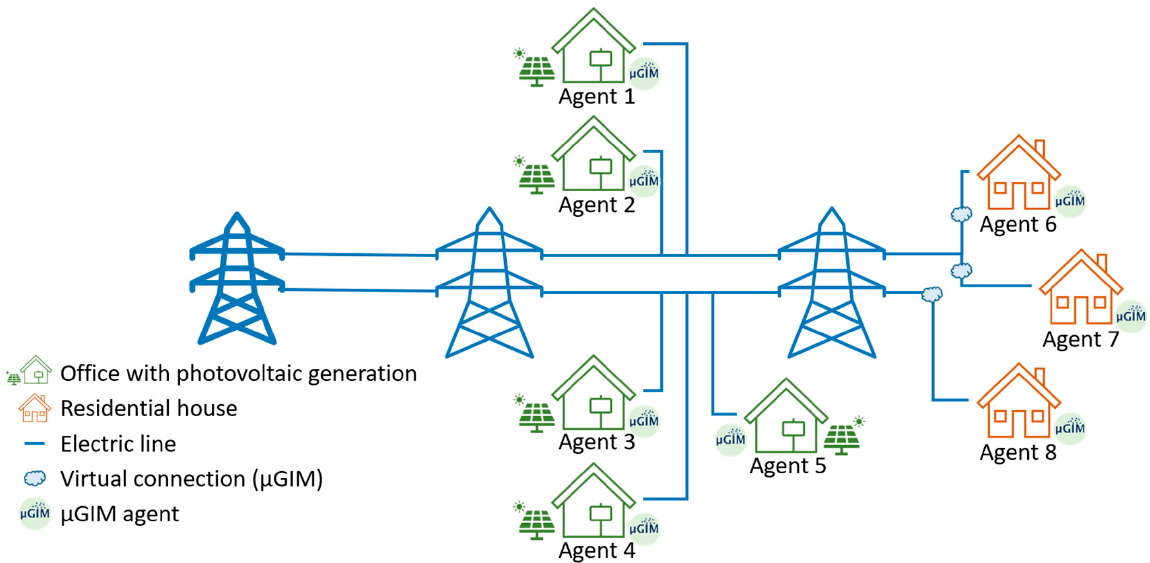
Figure 5. Energy community architecture considered in this case study.